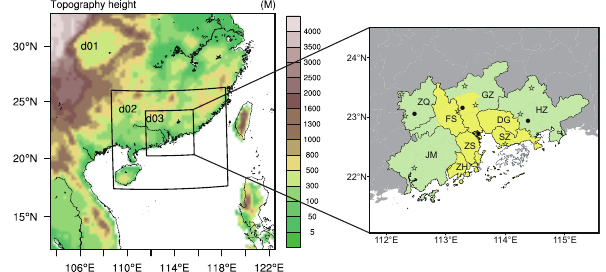
Fig. 1. Modeling domains, topography, location of meteorological monitoring sites (star) and air quality monitoring sites (filled circle). Definition of the three regions: grey area is the outside PRD; green area is the rural PRD; yellow area is the central PRD.